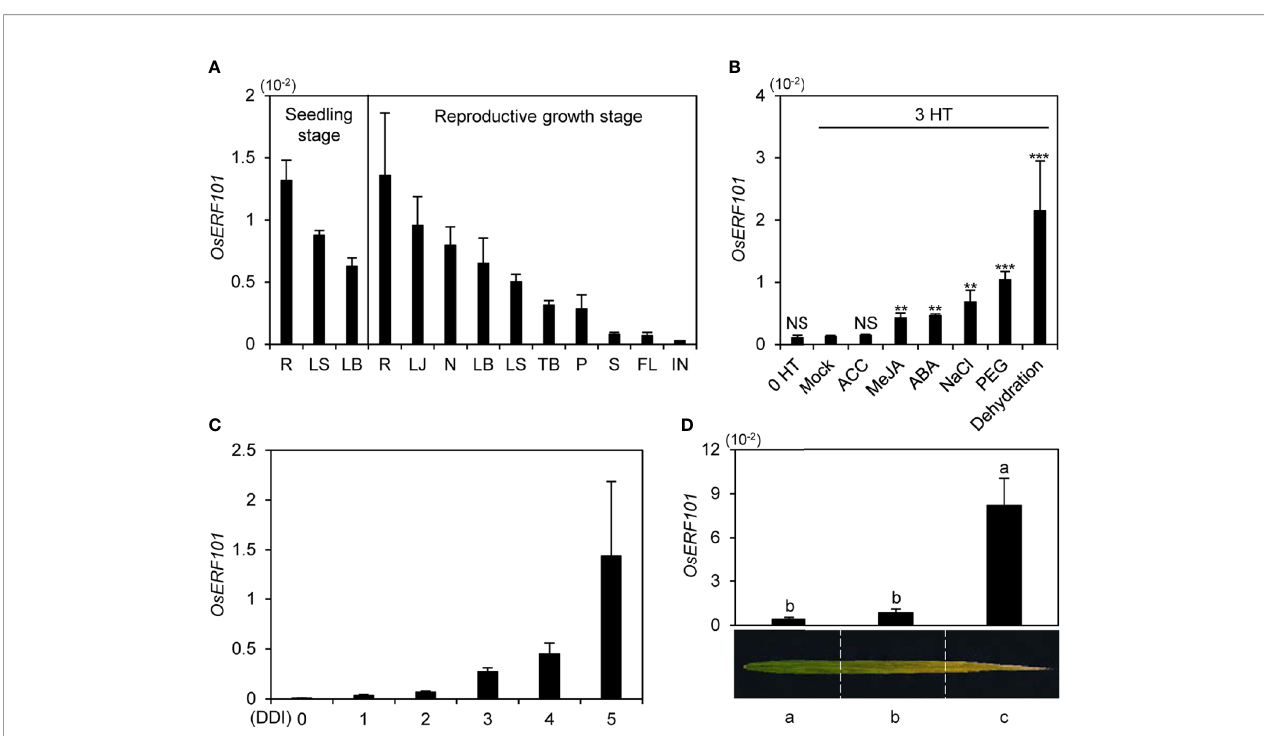
FIGURE 1 | Expression pro fi les of OsERF101 . (A) OsERF101 was differentially expressed in various japonica cultivar ’ Dongjin ’ (hereafter wild type; WT) tissues: root (R), leaf sheath (LS), leaf blade (LB), lamina joint (LJ), node (N), tiller base (TB), panicle (P), stem (S), fl ag leaf (FL), and internode (IN). WT seedlings were grown in a growth chamber for 3 weeks under long-day (LD) conditions (14 h light/10 h dark). WT plants were cultivated in a paddy fi eld until the reproductive stage at 120 days after seeding (DAS) under natural long-day (NLD) conditions (>14 h light/day). (B) Expression patterns of OsERF101 in response to abiotic stresses and phytohormones. WT seedlings grown in half-strength Murashige and Skoog (1/2 MS) solid medium for 10 d under continuous light at 28°C were incubated in 1/2 MS liquid medium supplemented with 100 µM ACC, 100 µM MeJA, 100 µM ABA, 100 mM NaCl, or 20% PEG or dehydrated by air drying. Seedlings incubated in 1/ 2 MS liquid medium without treatment were used as a mock control. Total RNA was isolated from the leaves at 0 and 3 h of treatment (HT). Asterisks indicate statistically signi fi cant differences between treated samples and the mock control, as determined by Student ’ s t-test (** p < 0.01, *** p < 0.001). NS, not signi fi cant. (C) OsERF101 expression gradually increased in detached leaves of 3-week-old WT plants grown in a growth chamber under LD conditions. Detached leaves were subjected to complete darkness in 3 mM MES (pH 5.8) at 28°C. (D) Expression of OsERF101 was measured in fl ag leaves divided into three regions from the green sector (a) to the yellow sector (c) at the ripening stage (130 DAS). OsERF101 mRNA levels were determined by qRT-PCR analysis and normalized to that of OsUBQ5 (Os01g22490). Mean and standard deviations were obtained from at least three biological samples. Different letters indicate signi fi cantly different values according to a one-way ANOVA and Duncan ’ s least signi fi cant range test ( p < 0.05). Experiments were repeated twice with similar